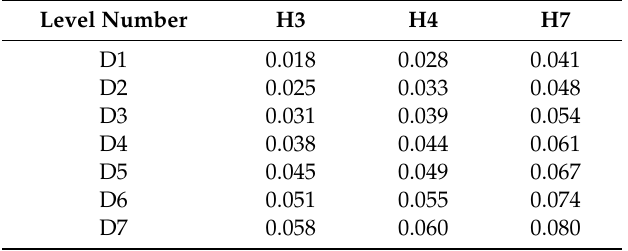
Table 3. Definition of threshold levels for novel data compression